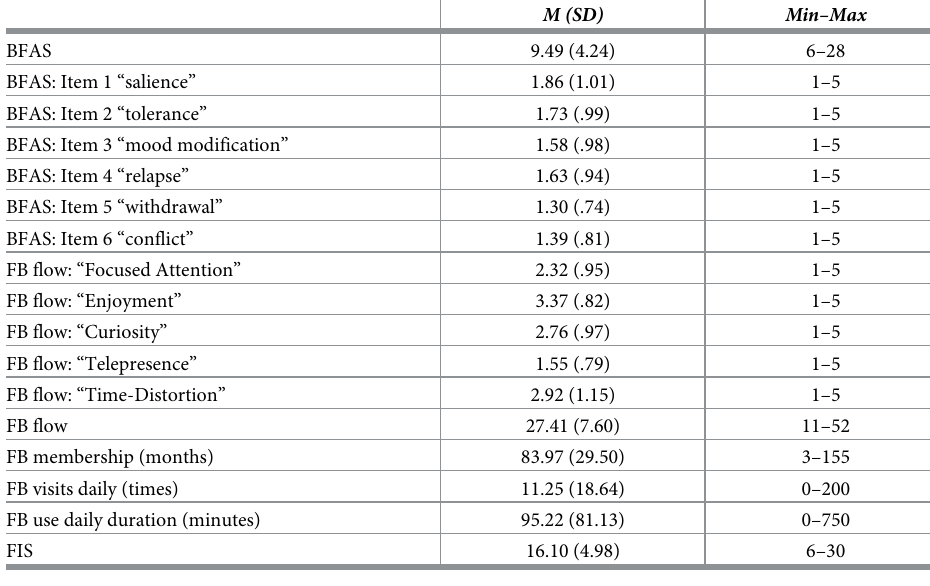
Table 2. Descriptive statistics of investigated